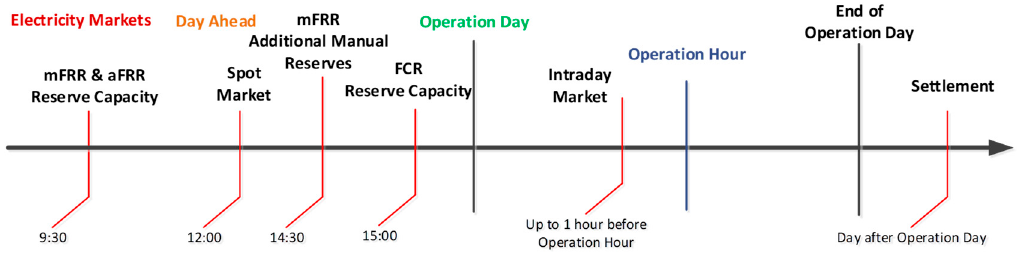
Figure 2. Overview of Nordpool’s auctions (based on [4,5]).